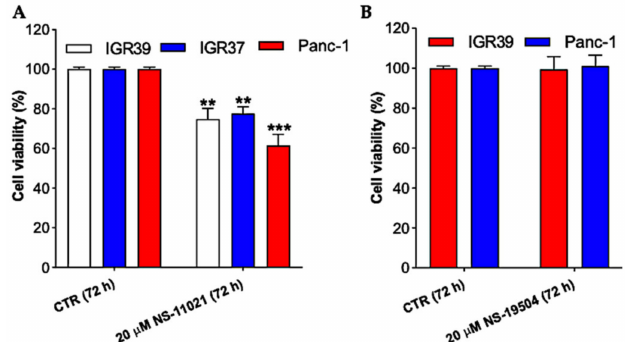
Figure 5. In vitro effects of BK channel openers on cell viability. Cells were treated with ( A ) 20 µ M NS- 11021 or ( B ) 20 µ M NS-19504 for 24 h. The 0.1% DMSO (maximal percentage used in the treatments) had no obvious cytotoxicity. ** p < 0.01 and *** p < 0.001 versus control (CTR) as determined by one-way ANOVA followed by Dunnet’s post hoc test ( n = 3).